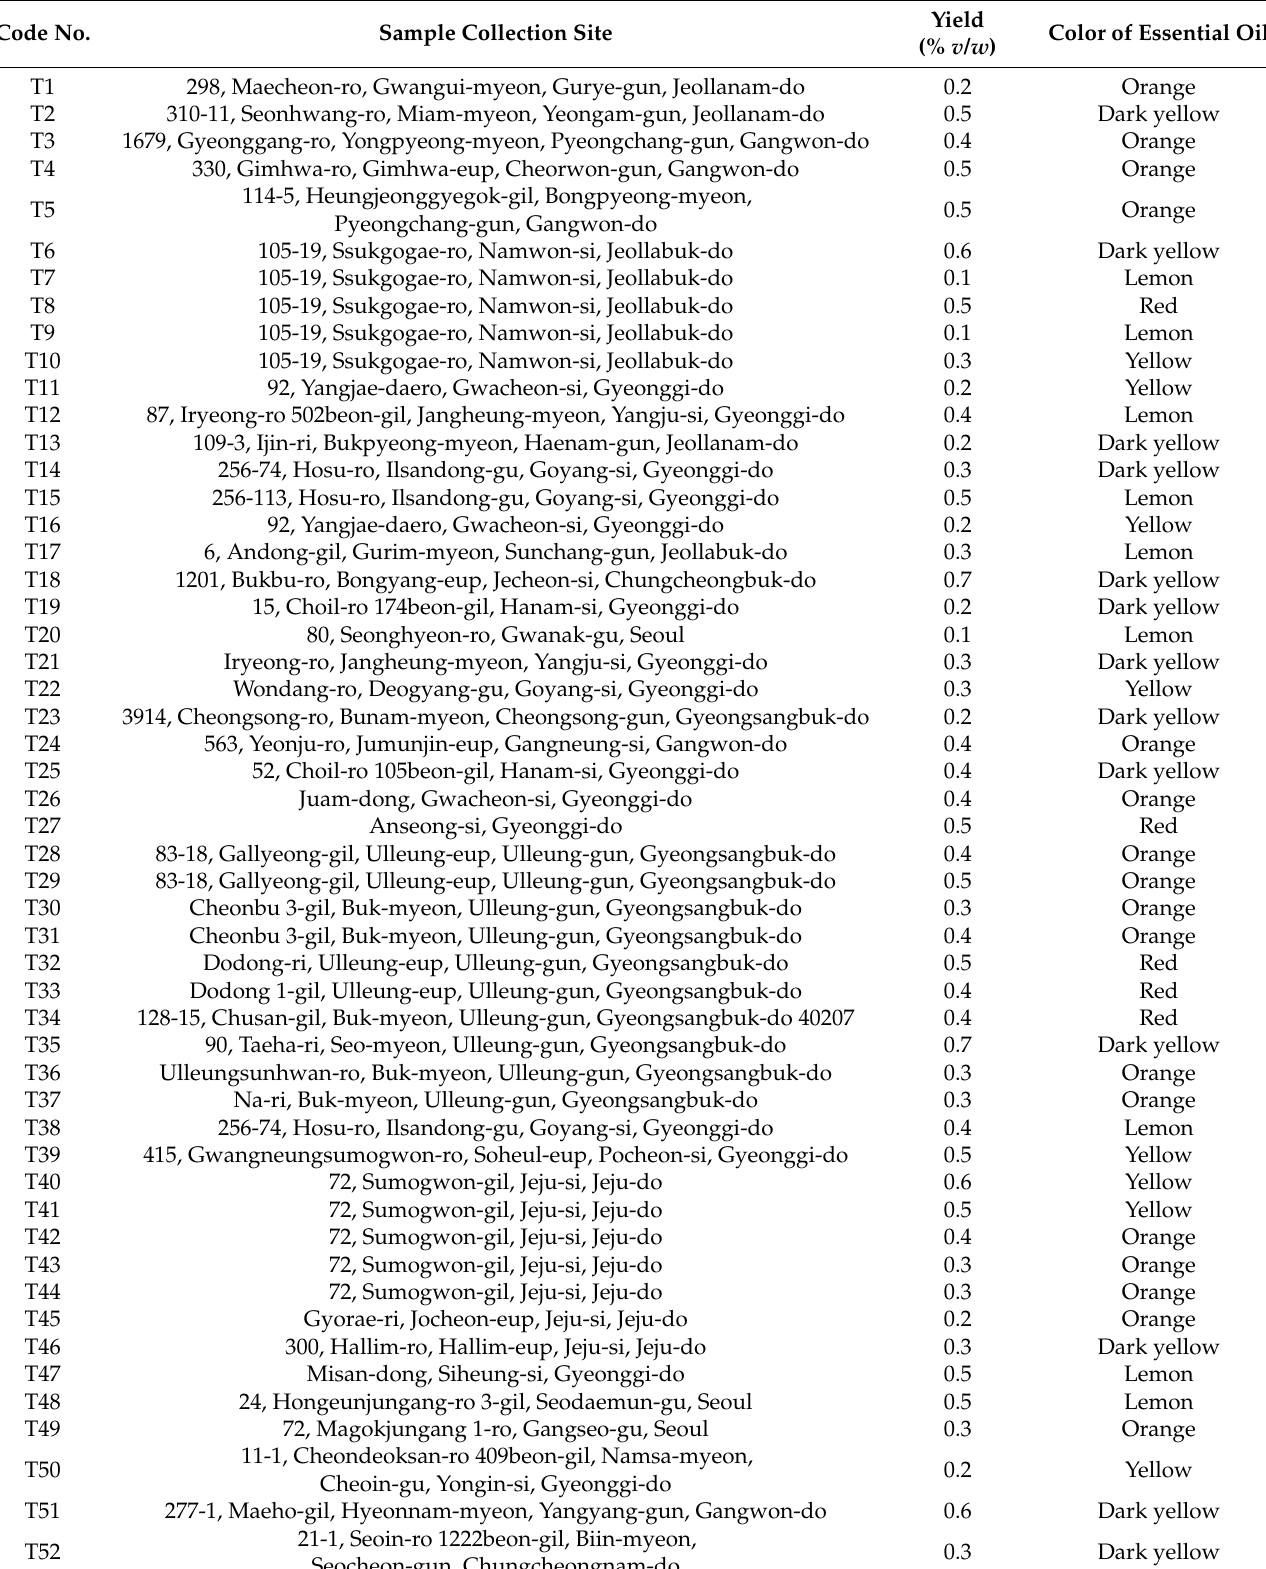
Table 1. Sampling sites of T. quinquecostatus and their essential oil